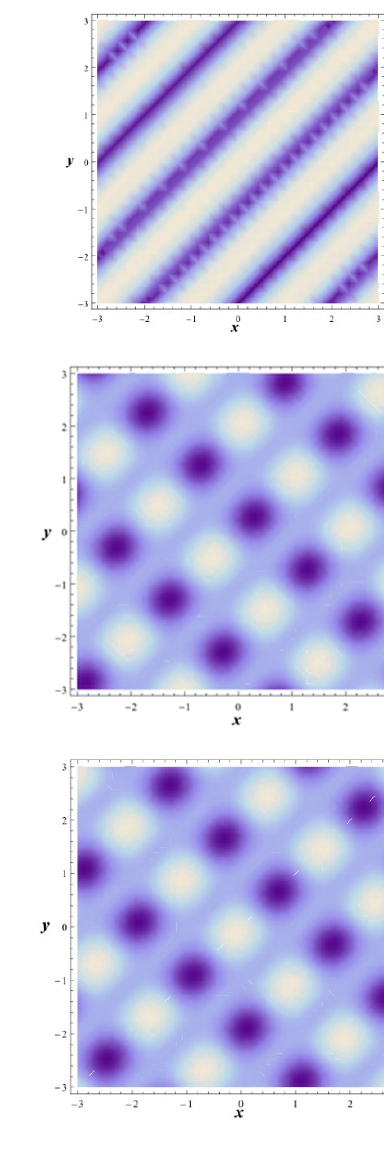
Figure 1. The AP, RP and IP of the PWS given by Equation (42) at t = 1. ( A ) The performance of p ( x , y , t ) . ( Aa ) The 3-D plot and density contour of the AP. ( Ab ) The 3-D plot and density contour of the RP. ( Ac ) The 3-D plot and density contour of the IP. ( B ) The performance of q ( x , y , t ) . ( Ba ) The 3-D plot and density contour of the AP. ( Bb ) The 3-D plot and density contour of the RP. ( Bc ) The 3-D plot and density contour of the IP.